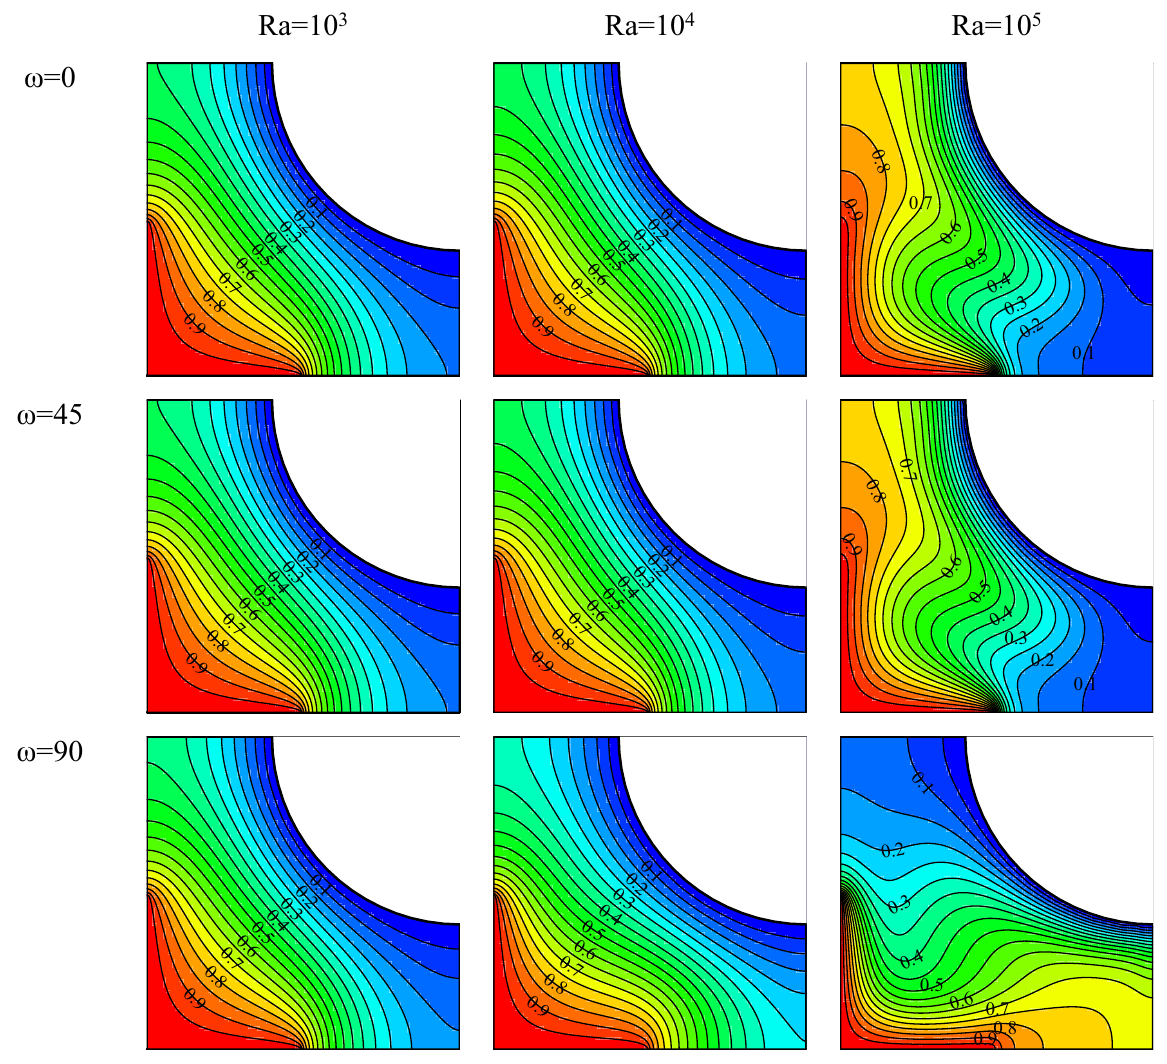
Figure 4. Temperature field for Ha = 20, Rd = 1, ϕ = 0.03, γ = 45 ◦ and various Rayleigh numbers and magnetic field